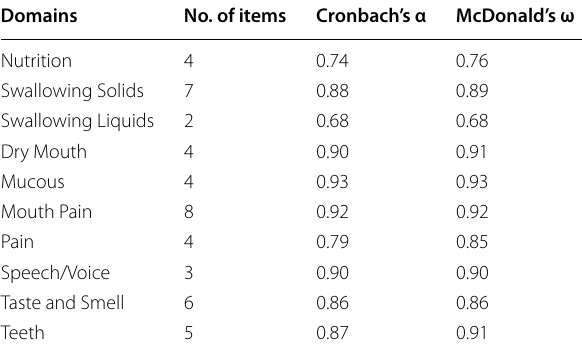
Table 4 Internal consistency using Cronbach’s alpha